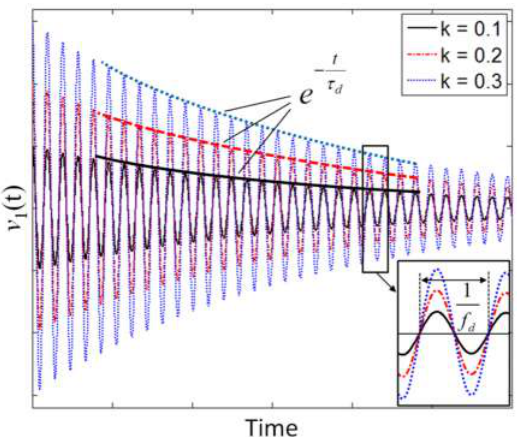
Figure 6. Voltage v 1 (t) during the detection phase calculated for three different values of the coupling factor k.